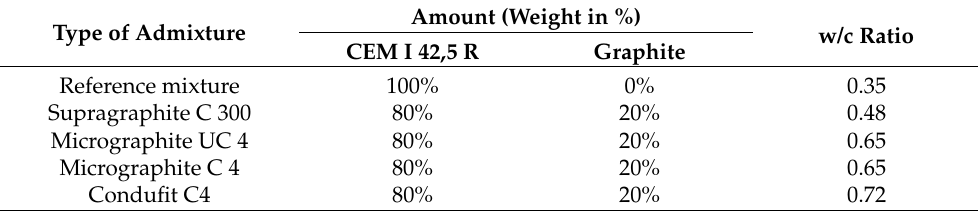
Table 7. The composition of cement pastes with the addition of conductive fillers.